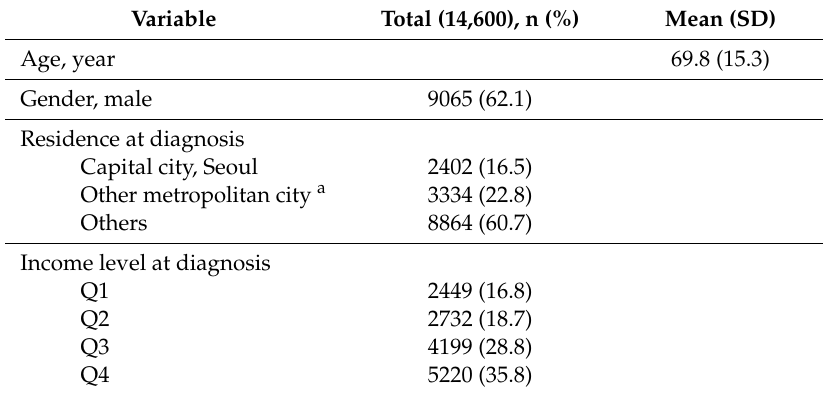
Table 1. Baseline characteristics of acute respiratory distress syndrome (ARDS) patients in South Korea from 2013 to